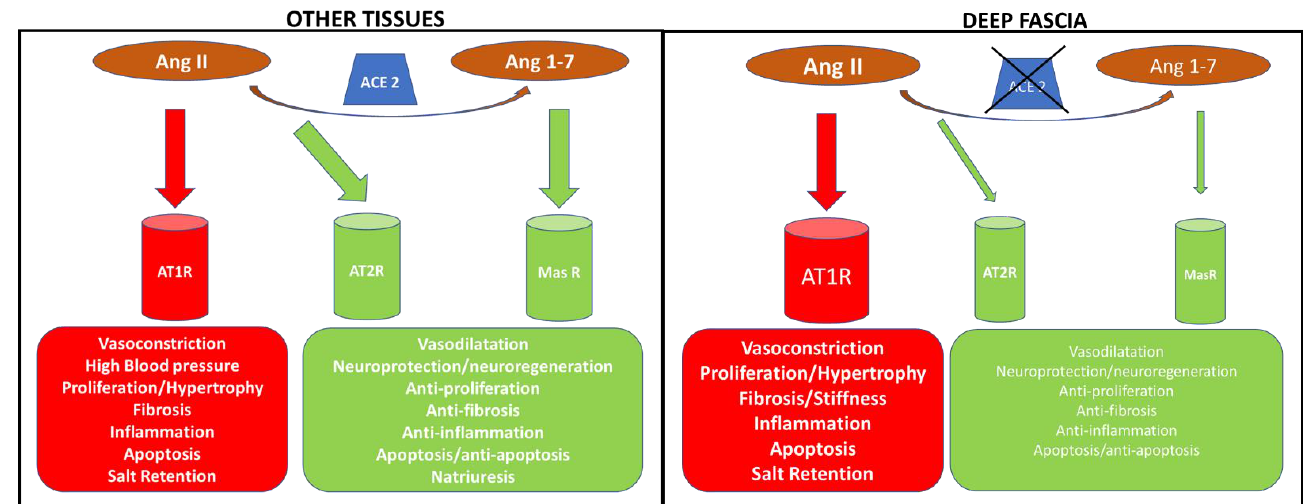
Figure 7. Schematic representation of the RAS system in tissues ( left panel) and deep fascia ( right panel), underlining the different effects exerted by angiotensin via RAS receptors, as reported in the literature for the other tissues and as we hypothesized in deep fascia. The Ang II effects via AT1R on the deep fascia are under investigation. Ang II: angiotensin II; Ang 1-7: angiotensin 1-7; AT1R: AngII type 1 receptor; AT2R: Ang II type 2 receptor; MasR: Mas receptor; ACE2: angiotensin-converting enzyme 2; ACE1: angiotensin-converting enzyme 1.